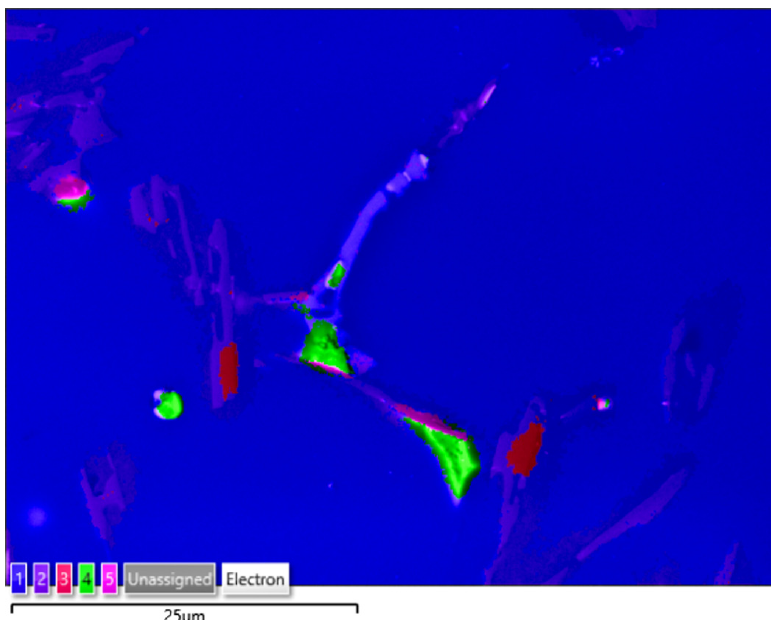
Figure 17. Spectrum of elements—AlSi10Sn1.7 alloy.